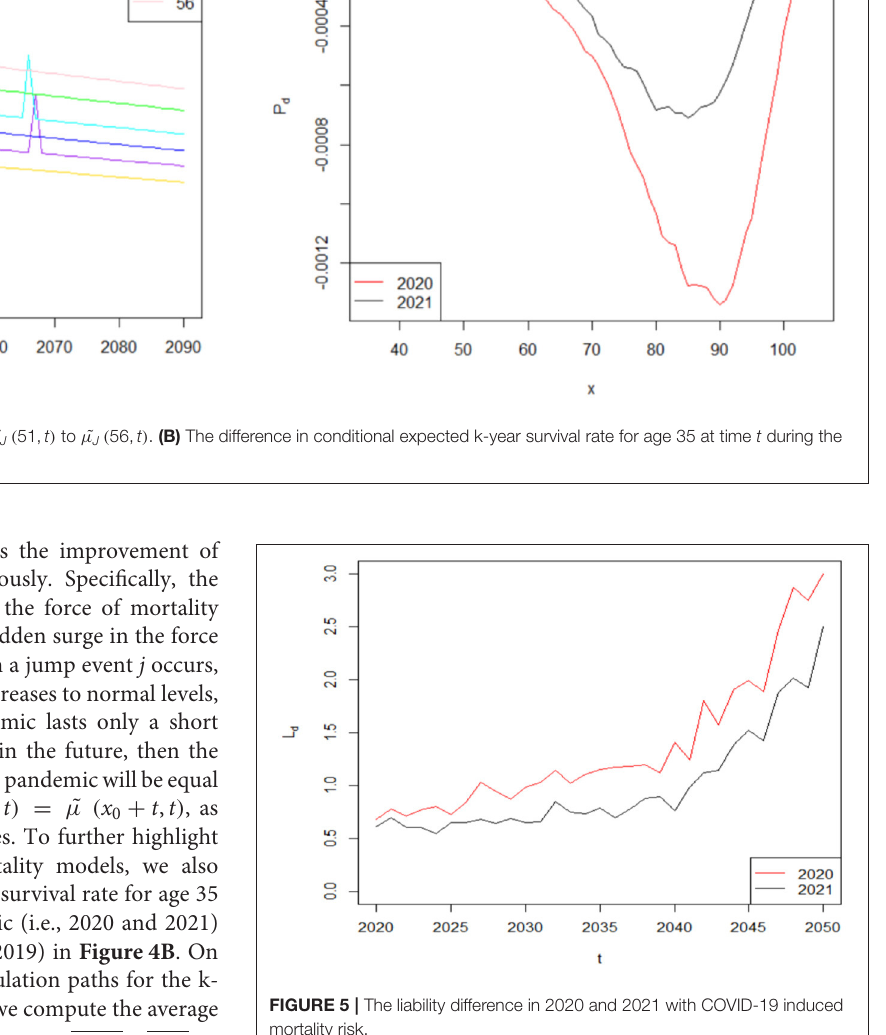
FIGURE 5 | The liability difference in 2020 and 2021 with COVID-19 induced mortality